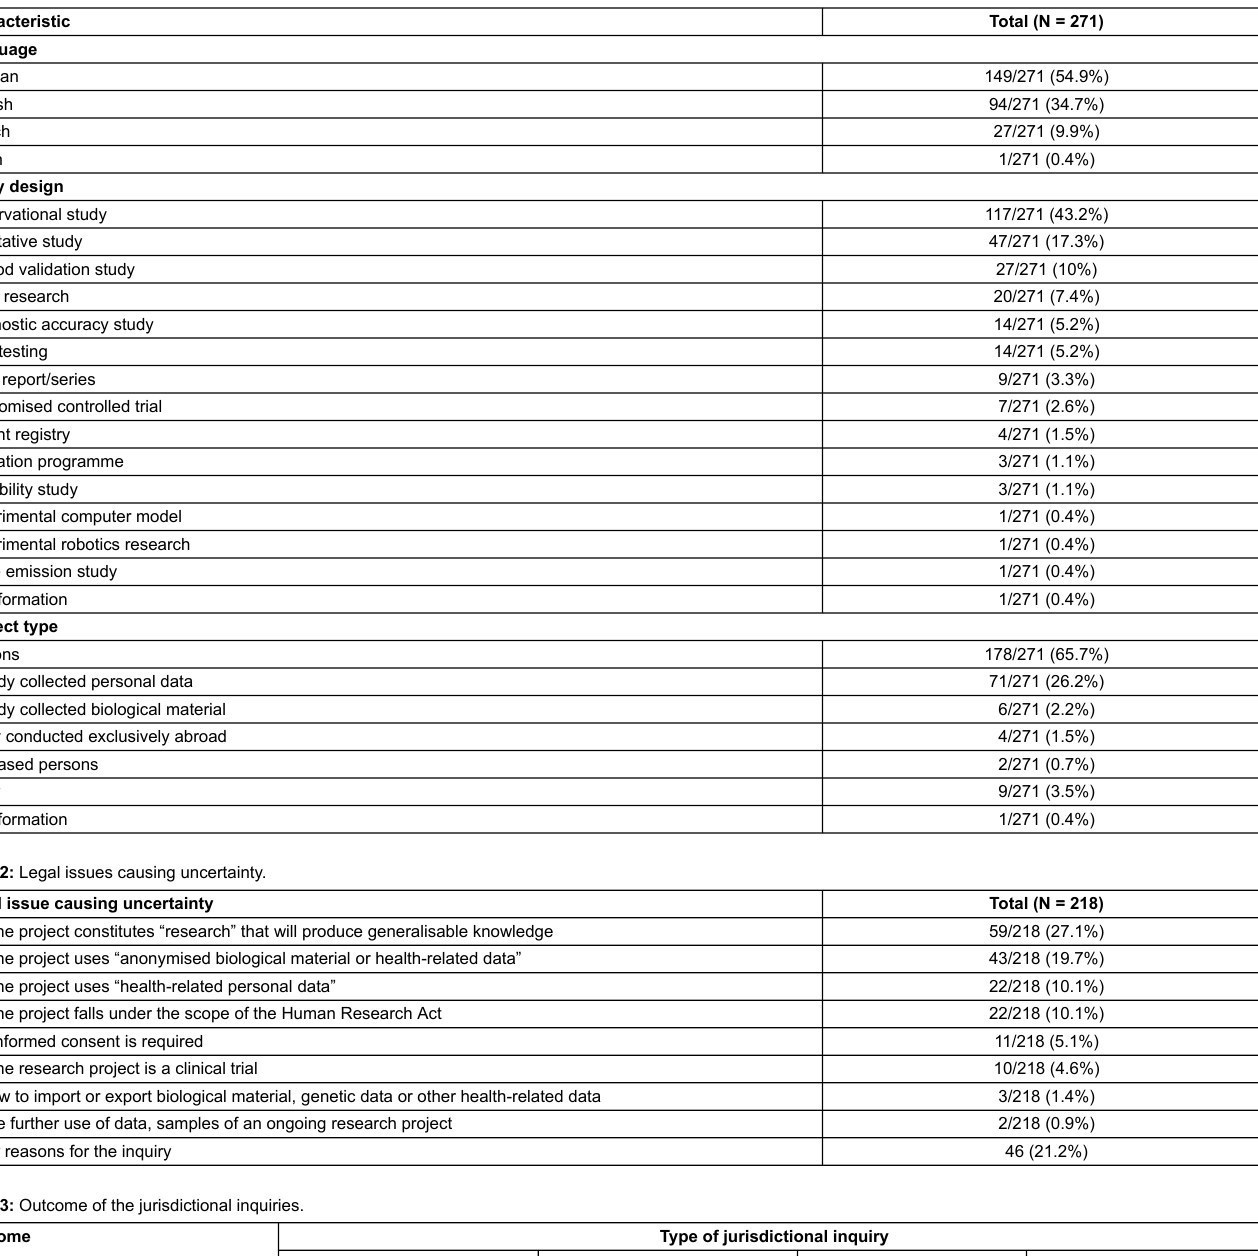
Table 1: Characteristics of the jurisdictional inquiries included.